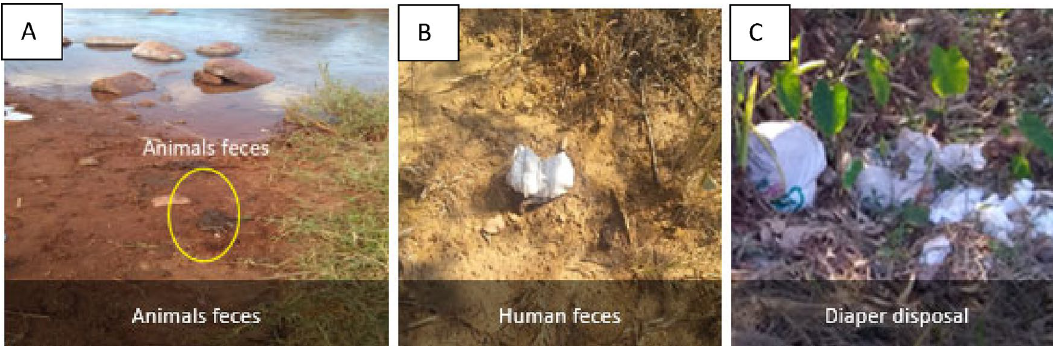
Figure 2. Human activities that contribute to contaminating water sources in the area. ( A ) Animal faeces located near the river; ( B ) open defaecation in the bush; ( C ) disposable diaper waste in the valley near the dam.